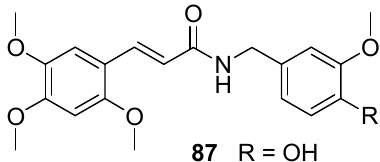
Figure 24. Structures of cinnamic acid derivatives effective against Protein Tyrosine Phosphatase 1B (PTP1B) [13]. The most potent compounds with effective neurological activity are compounds 86f–h. They were active against both hAChE and hBuChE when compared to donepezil in vitro [60]. There is a pressing need for these compounds to be evaluated in vivo. 6. Cinnamic Derivatives with Antidiabetic Activity Diabetes mellitus is characterized as a metabolic disorder that results from a defect in insulin action, secretion or both [62]. The International Diabetes Federation estimated the global prevalence of diabetes mellitus to increase to 591 million by 2035 from 382 million reported in 2013. The inability to regulate blood glucose also causes many complications such as angiopathy, retinopathy and